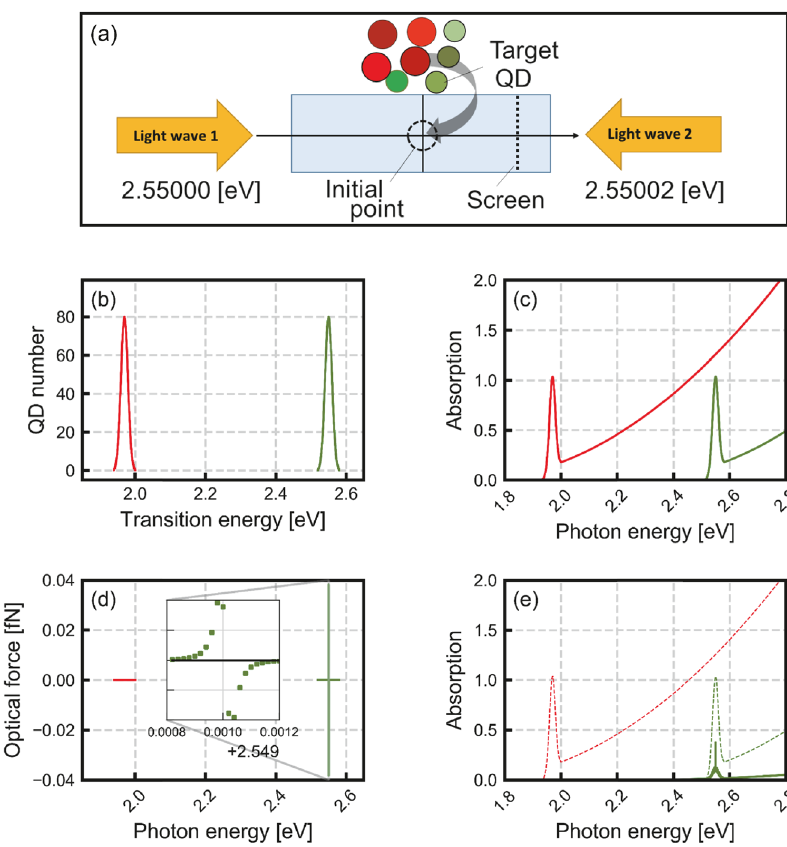
represented by dotted lines for